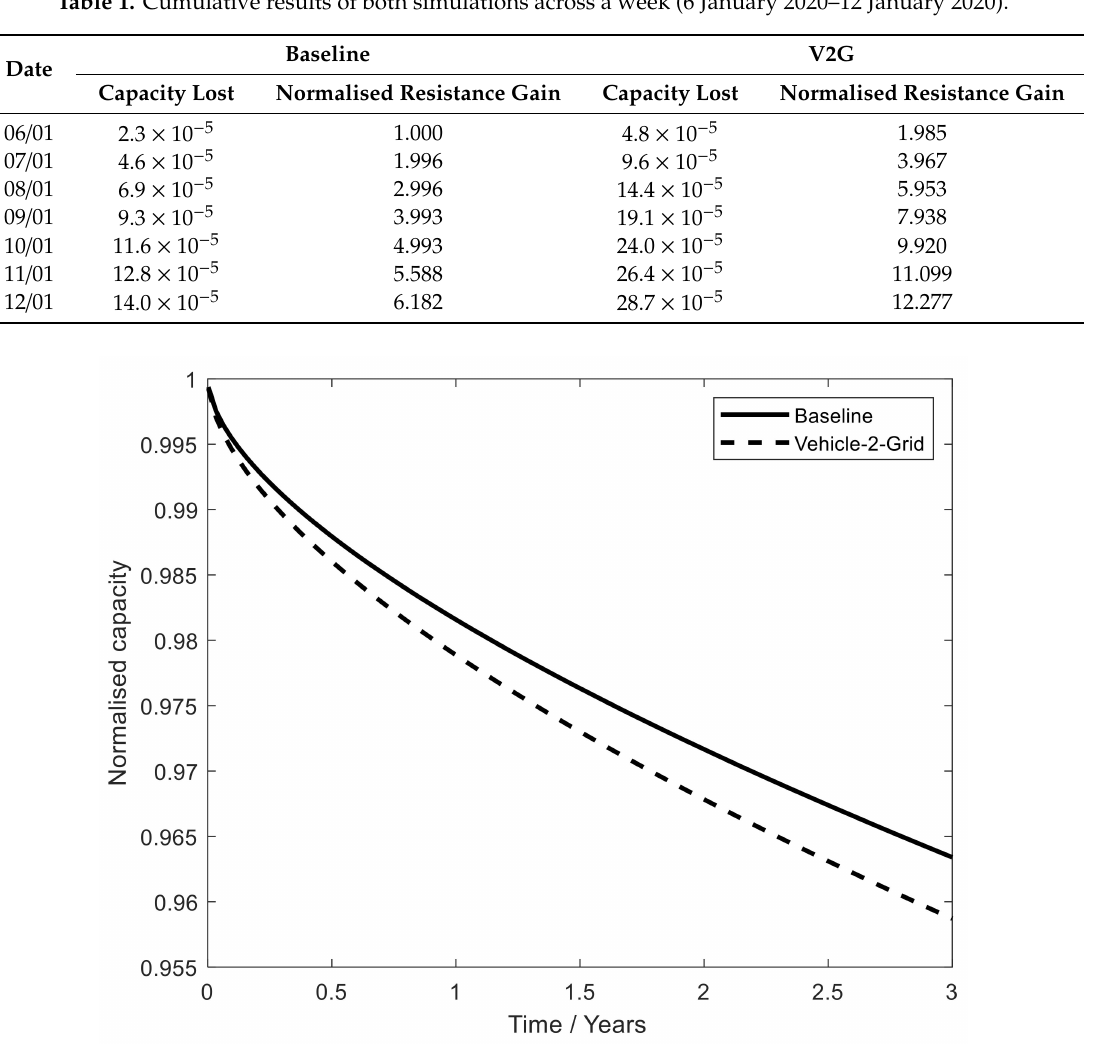
Figure 7. A graphical representation of the cumulative fall in remaining capacity loss.